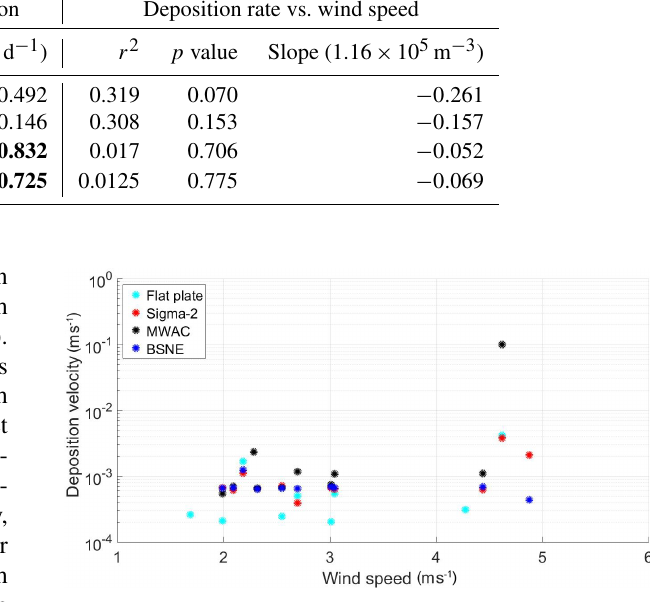
Figure 9. Apparent deposition velocity: ratio of number deposition rate determined from SEM measurements to the number concen- tration observed by the OPC as function of wind speed. For the consideration, only the overlapping size range (approximately 1– 10µm) was